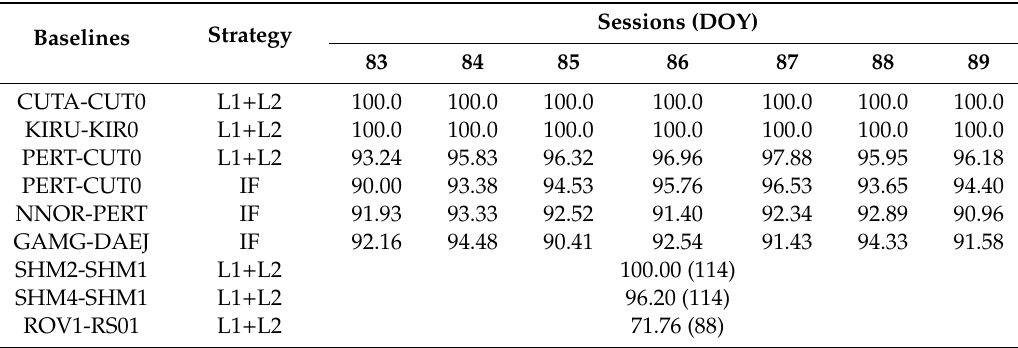
Table 3. Ambiguity resolution success rate statistics